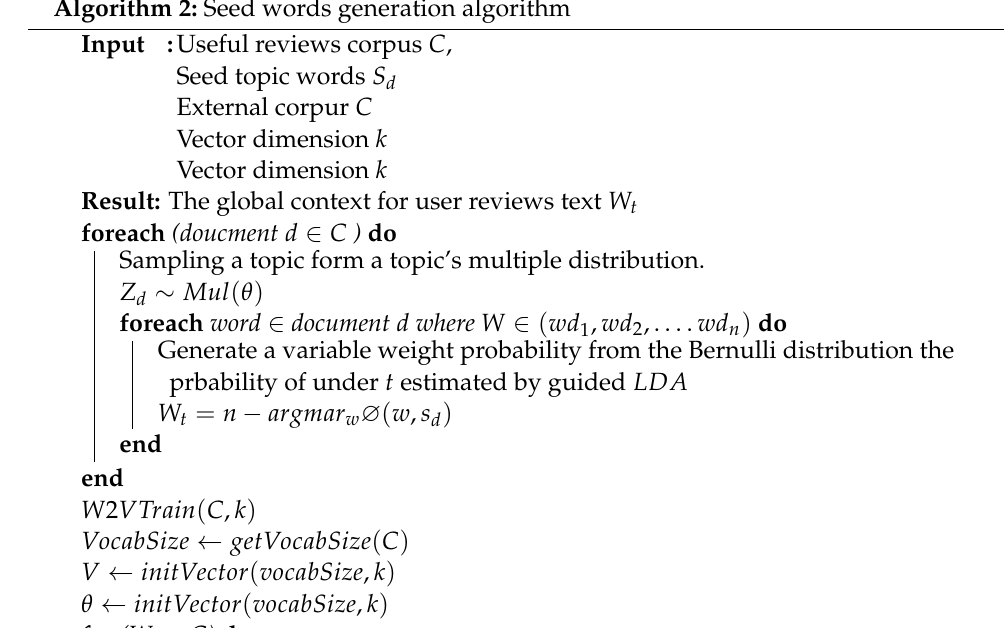
Algorithm 2: Seed words generation